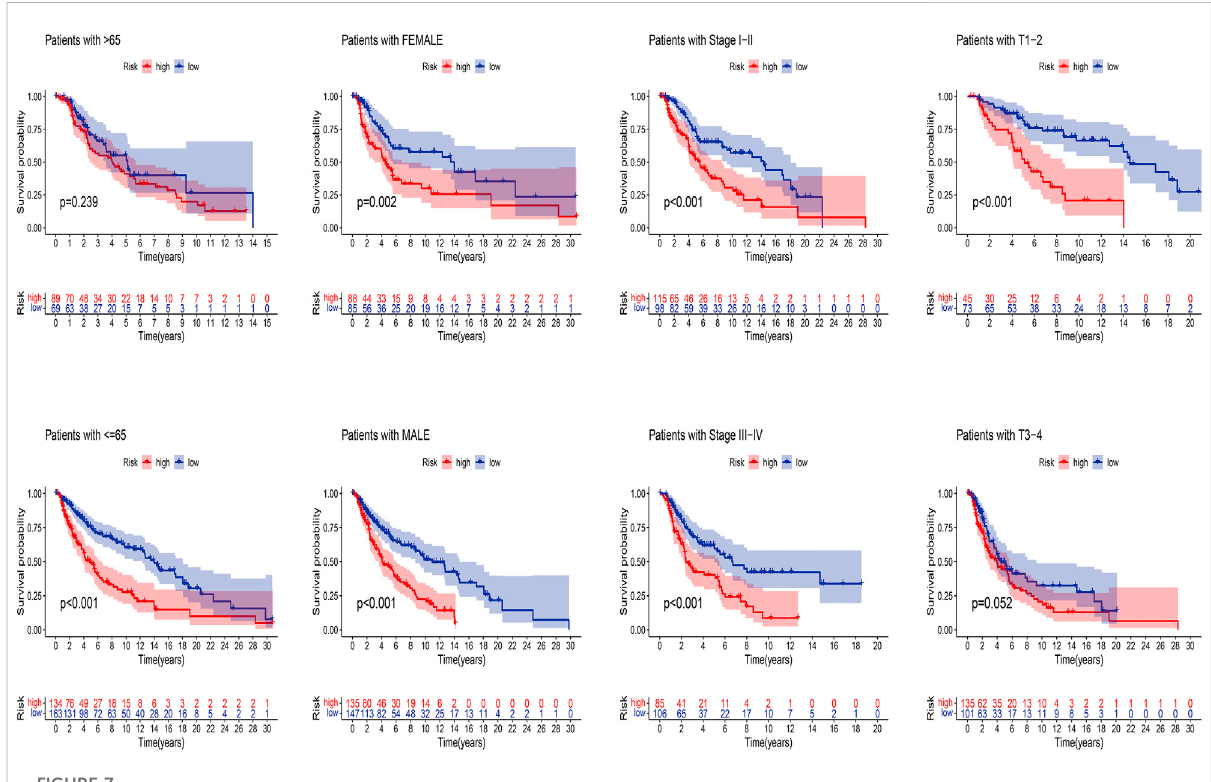
FIGURE 7 K-M analysis of OS strati fi ed by age ( ≤ 65 or > 65), gender (female or male), SKCM stage (I – II or III-IV), and TNM stage (T1 – 2 or T3 – 4) between high-risk and low-risk groups in TCGA entire